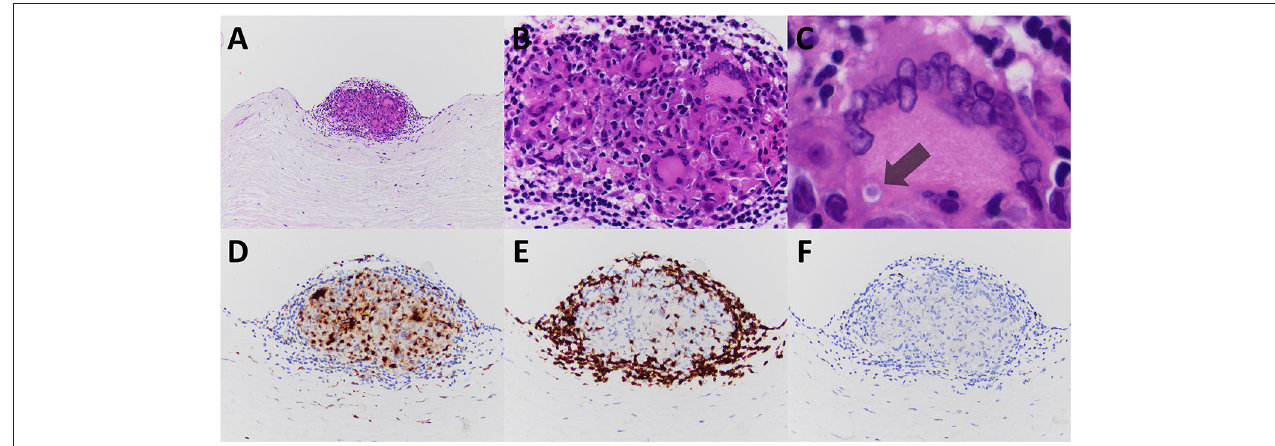
FIGURE 1 | The excised mitral valve of Patient #1 revealed a small well-formed non-necrotizing granuloma, nodular and on the valve surface ( A–C , hematoxylin and eosin stained paraffin sections). Immunoperoxidase staining for CD68, CD3, and CD20 highlighted the granuloma’s constituents of monocyte derived epithelioid histiocytes and multinucleated giant cells (D) , T-cell lymphocytes (E) , and few B-cell lymphocytes (F) , respectively. A multinucleated giant cell contains a rare cytoplasmic inclusion consistent with an asteroid body ( C , indicated with arrow). Original magnification for A at × 100; for B at × 400; for C at × 600; and for D–F at ×